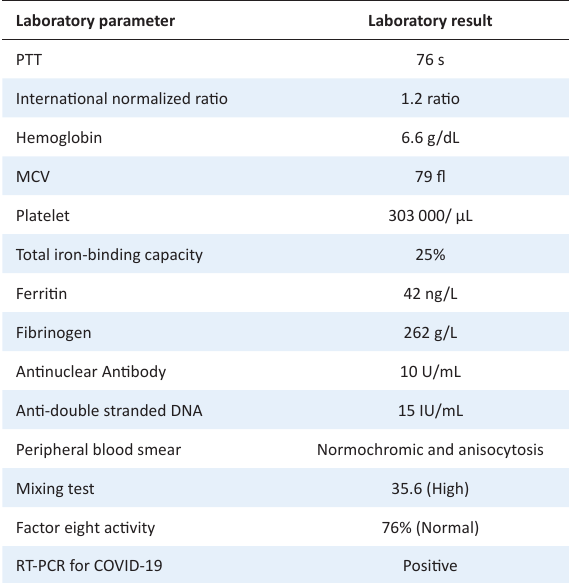
Table 1. The results of the patient’s laboratory